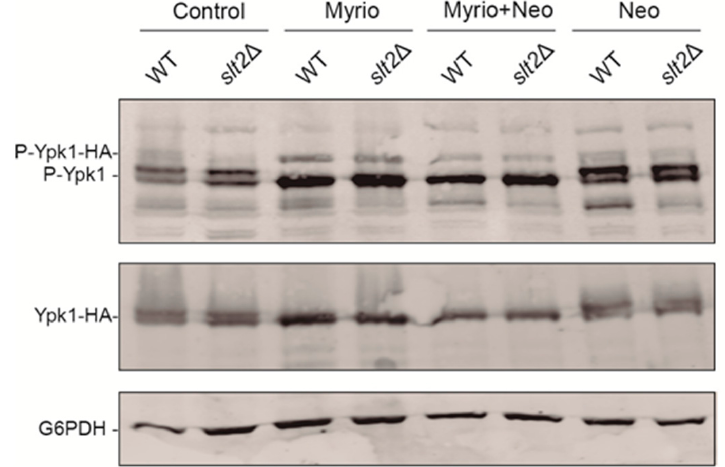
Figure 6. Western blotting of cell lysates of Y3656 and the isogenic slt2 ∆ strains transformed with plasmid pLB215 (Ypk1 ‐ HA) from untreated cultures (control) or treated with 0.8 mg/mL (2 μ M) myriocin for 2 h (Myrio), the combination of 0.8 mg/mL (2 μ M) and 5 mg/mL neomycin for 2 h (Myrio+Neo), or 5 mg/mL neomycin for 4 h (Neo), all of them cultured in YPD. Membranes were probed with anti ‐ phospho T662 ‐ Ypk1 (upper panel), anti ‐ HA (middle panel), and anti ‐ G6PDH (lower panel), as a loading control.